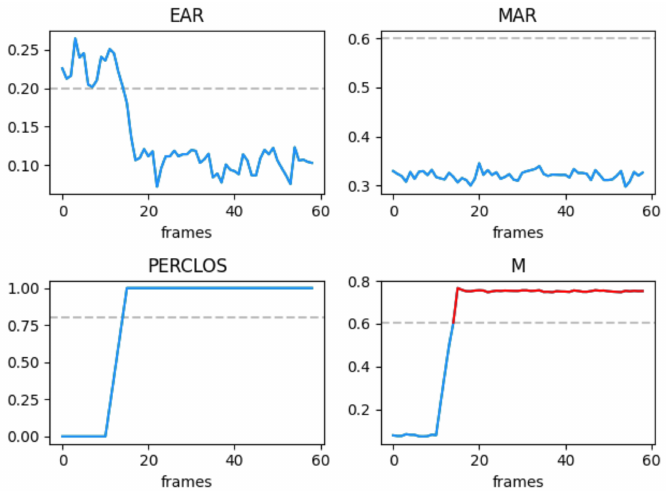
Figure 9. Fatigue test results of the driver without yawning.